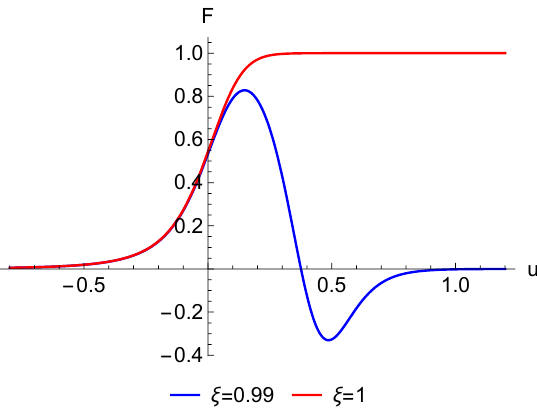
Figure 4 . Plot of energy (cid:13)ux, eq. (2.1), F , against u , for the trajectory eq. (1.6) (blue) with p (cid:20) = 48 (cid:25) and (cid:24) = 0 : 99. The scale of the system, (cid:20) , is chosen so that thermal emission is at F = 1 and a comparison with positive energy (cid:13)ux of the BHC mirror, eq. (1.8) (red), is illustrated. Negative energy (cid:13)ux is radiated by the asymptotically inertial